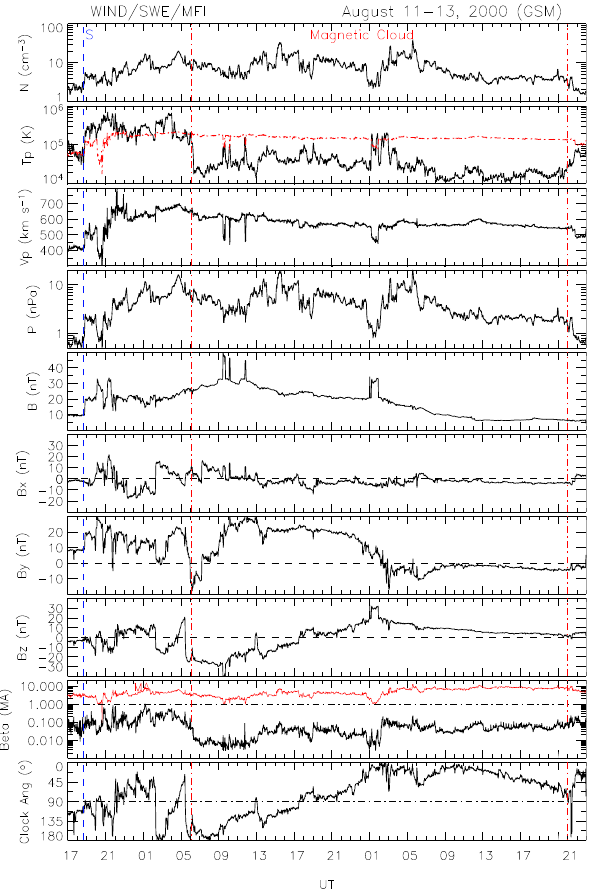
Fig. 5. Plasma and magnetic field data from spacecraft WIND for the interval 11 August (17:00UT)–13 August (24:00UT) 2000. Panels from top to bottom shows: proton density, temperature, bulk speed, dynamic pressure, total field, GSM components of the mag- netic field, proton plasma β and Alfv´en Mach number (red); and the clock angle, θ (polar angle in GSM Y-Z